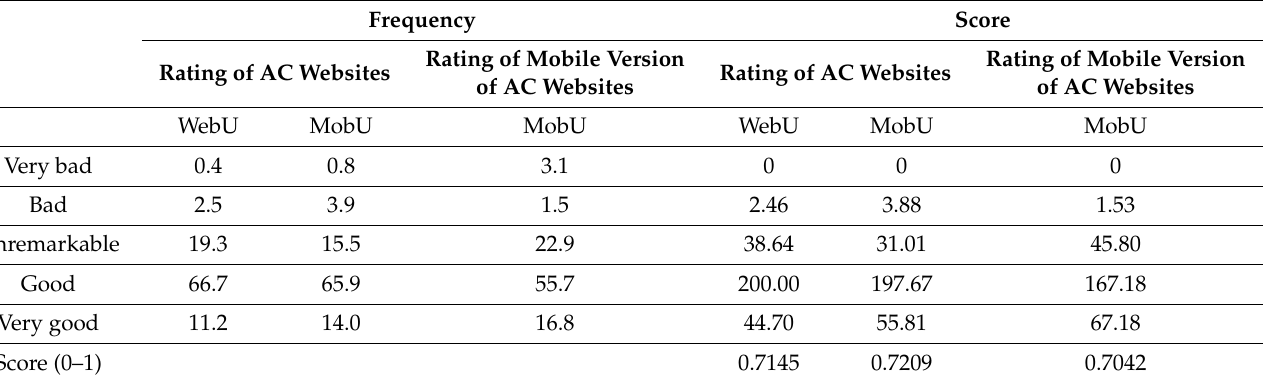
Table 2. Opinions of Autonomous Community health websites (by user profile).